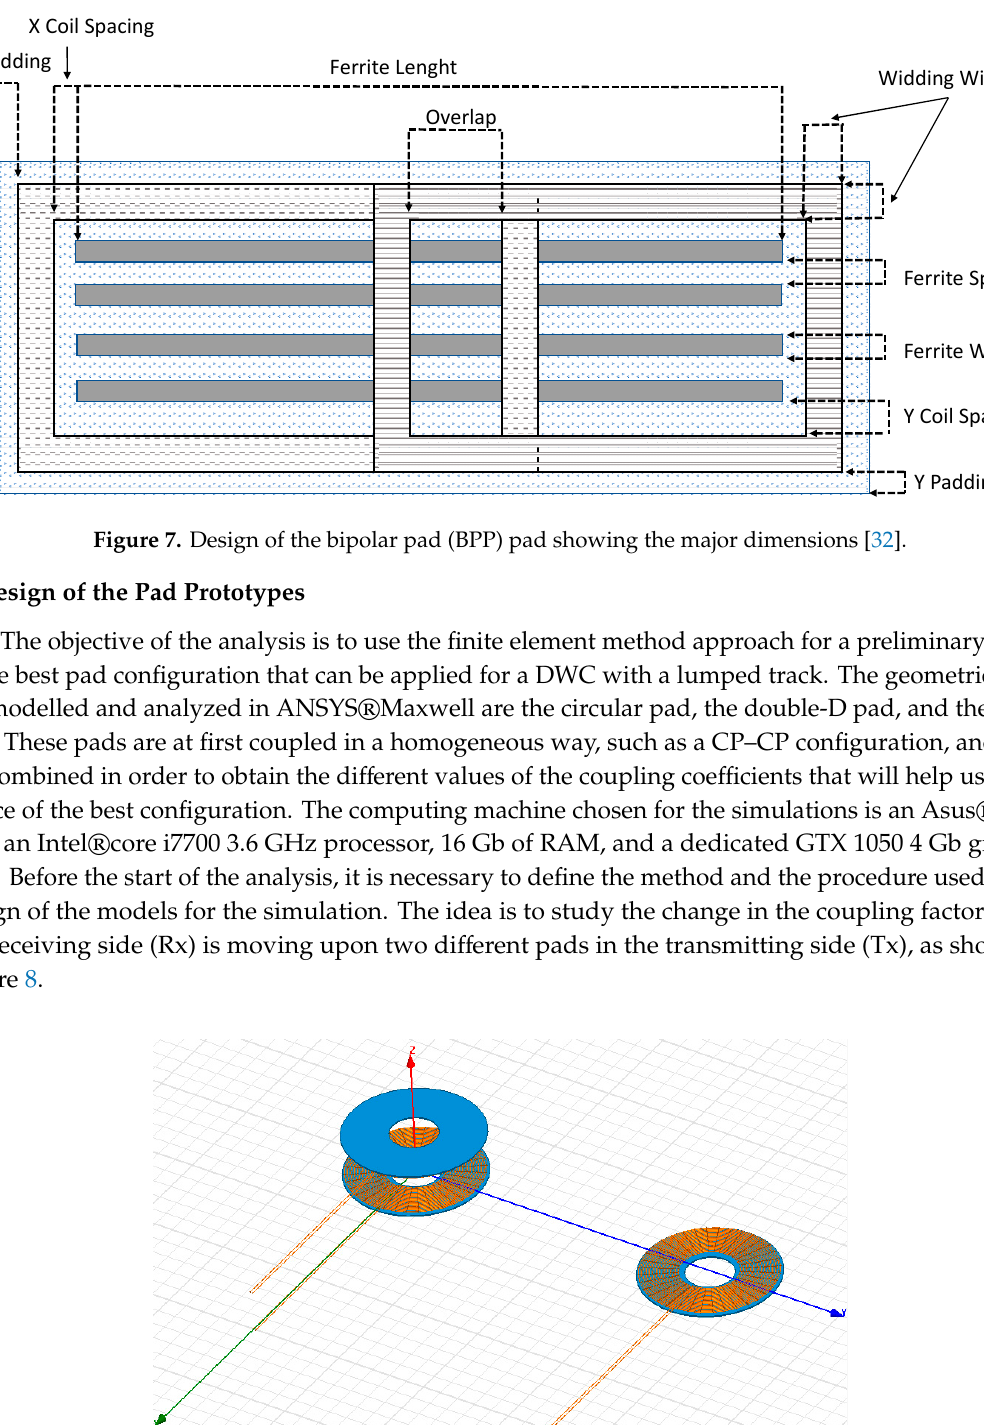
Figure 8. Disposition of a CP–CP configuration.